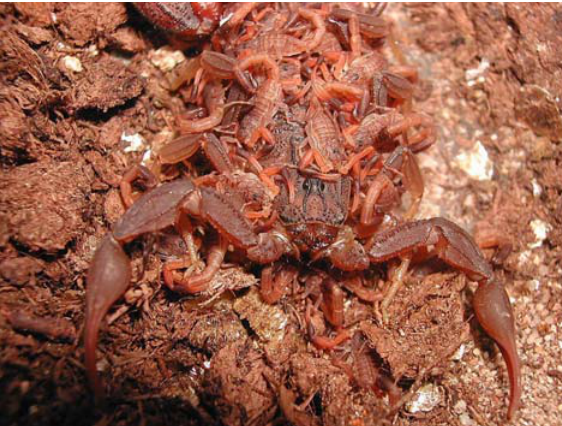
Figure 11. Parthenogenetic female of Hottentotta caboverdensis with brood.